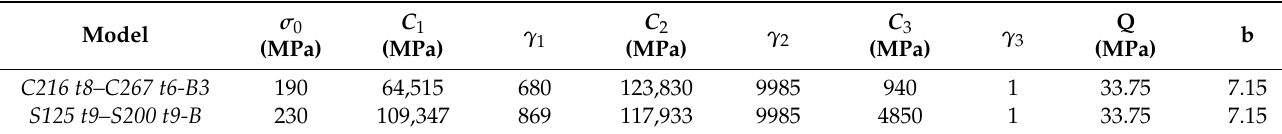
Table 7. Chaboche model